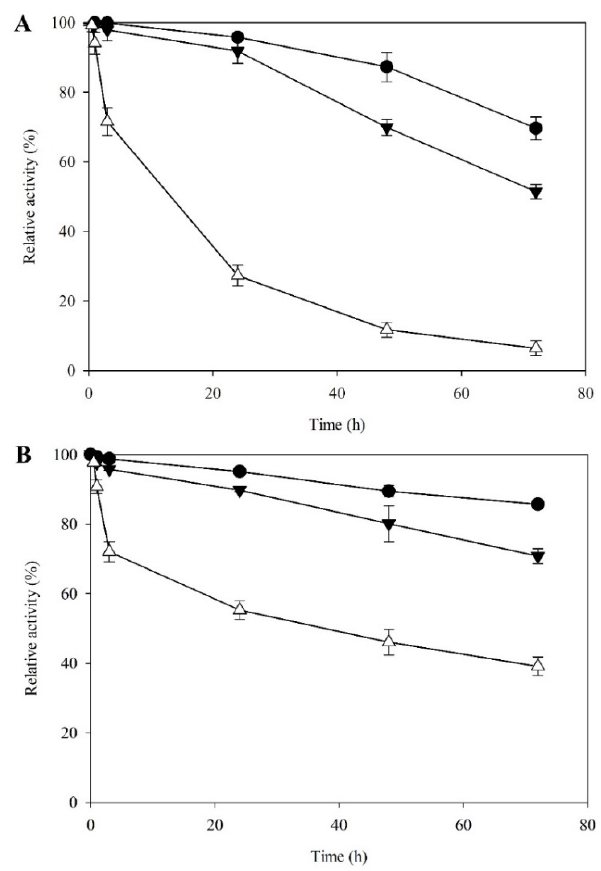
Figure 6. Time course of (A) laccase and (B) MnP stability under different wavelengths of light. Error bars represent standard deviation ( n = 3). Dark condition ( ), tungsten light ( ), and blue light ( ).